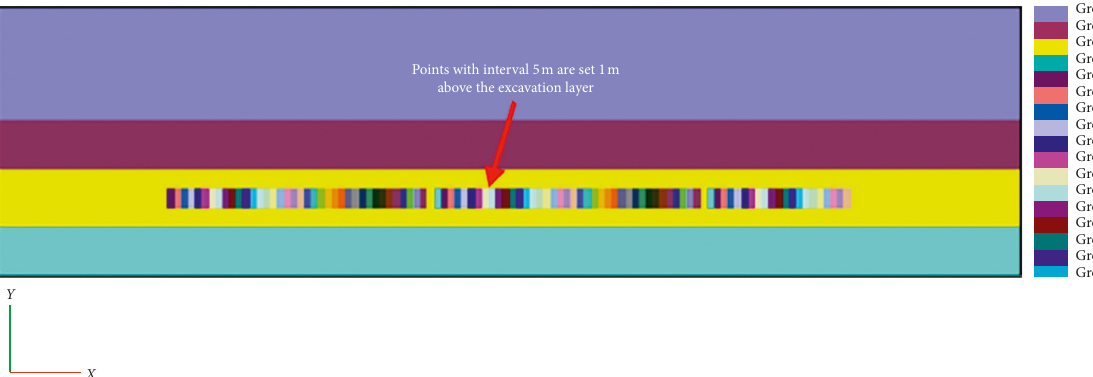
Figure 5: The numerical calculation